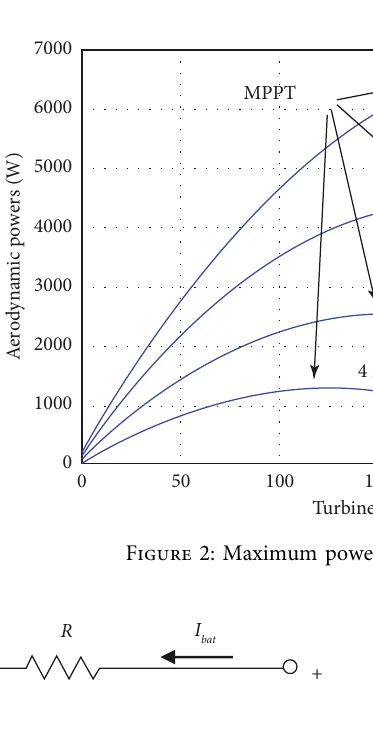
Figure 1: Configuration of the standalone hybrid energy system.